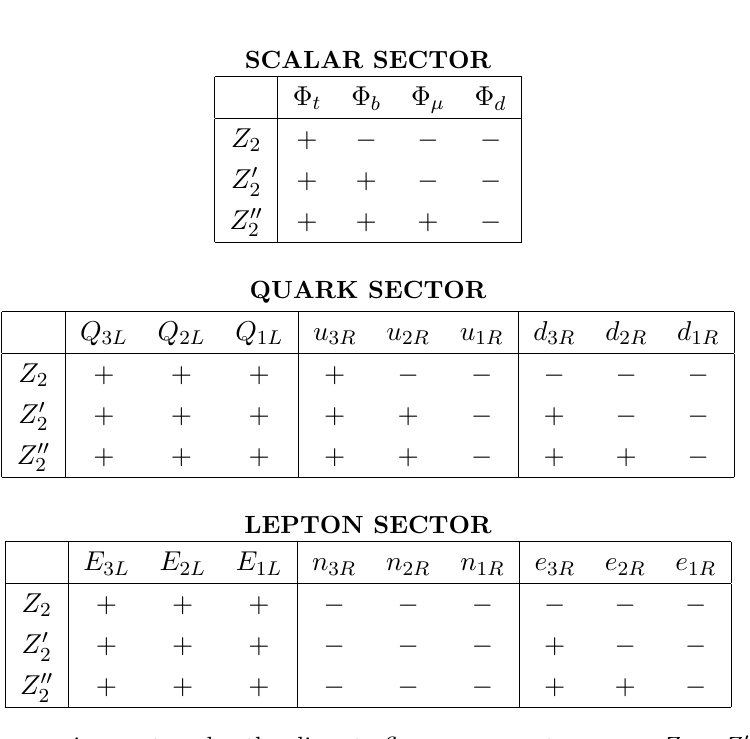
(cid:2) Z 00 for the 2 2